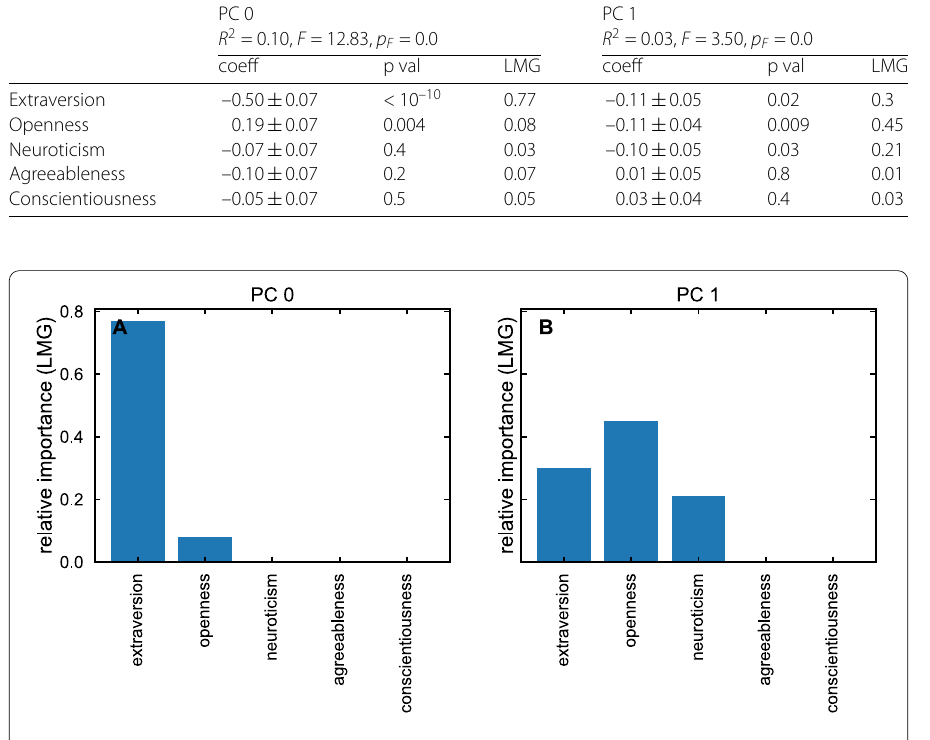
Figure 6 Relative importance of personality traits for spatial behaviour. LMG of each regressor computed using the Lindeman, Merenda and Gold method [79] for the multiple regression model of the principal components (see also Table